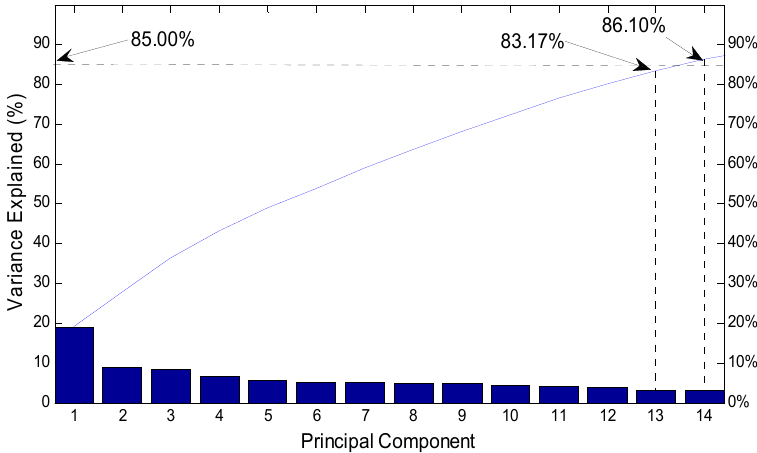
Figure 9. The variance explained by the principal components.